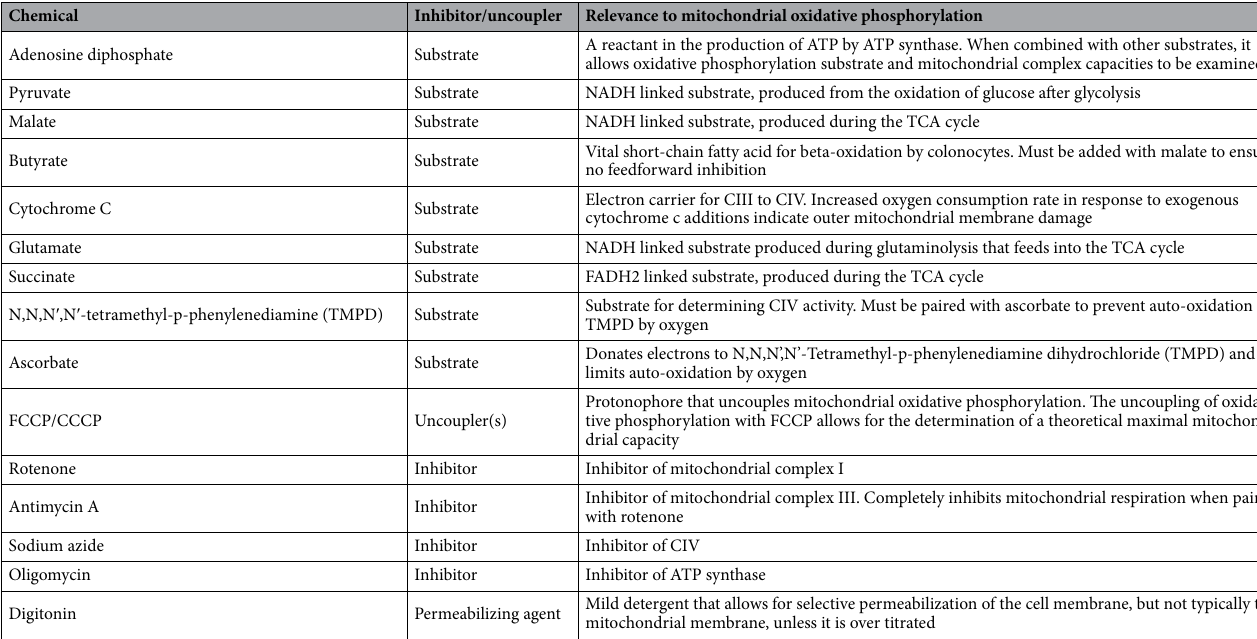
Table 1. Reagents and their effect on mitochondrial electron transport chain complexes or metabolic